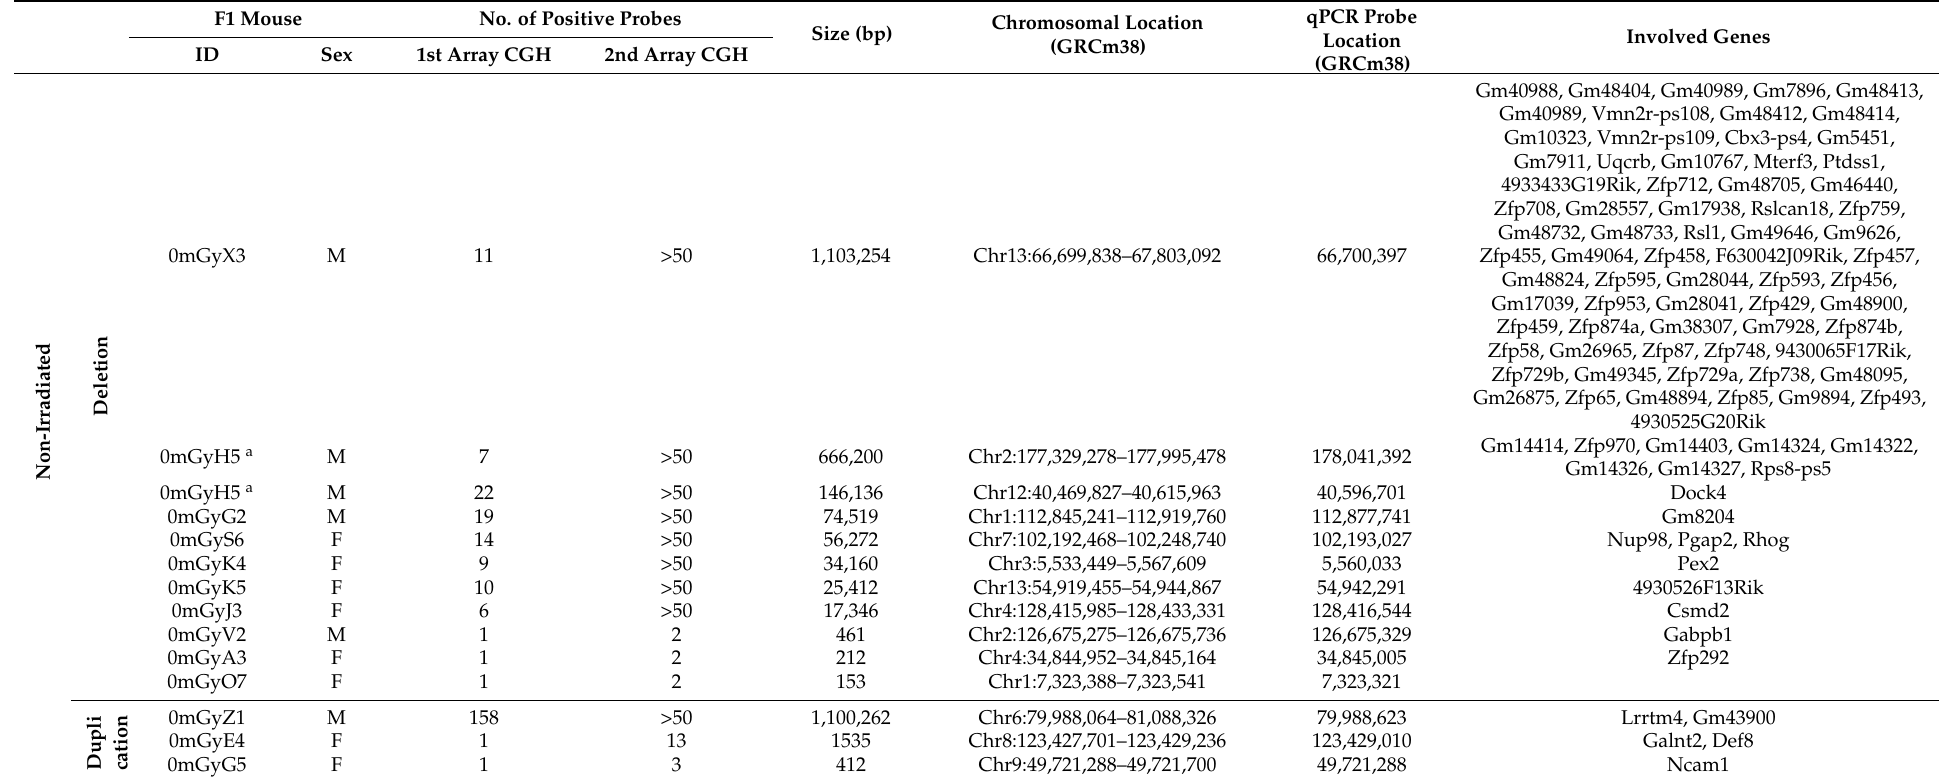
Table 1. List of confirmed de novo